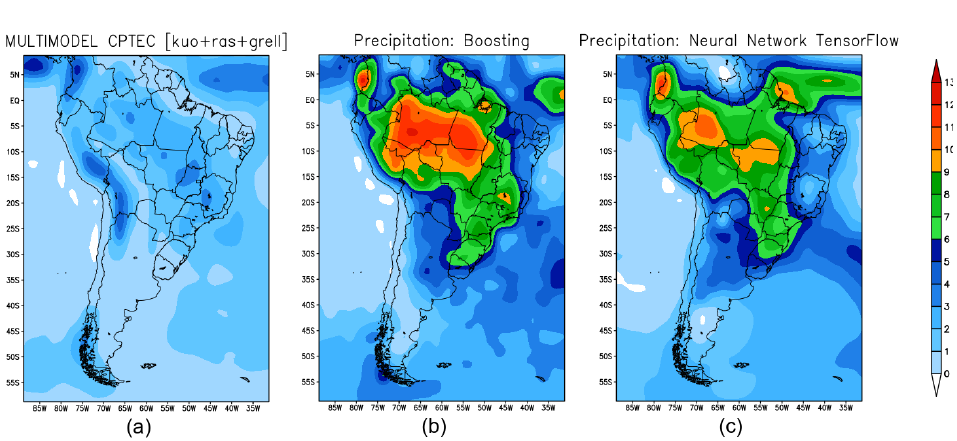
Figure 3. Seasonal climate prediction for the summer over South America: ( a ) precipitation predicted by the BAM; ( b ) prediction by XGB; ( c ) prediction by